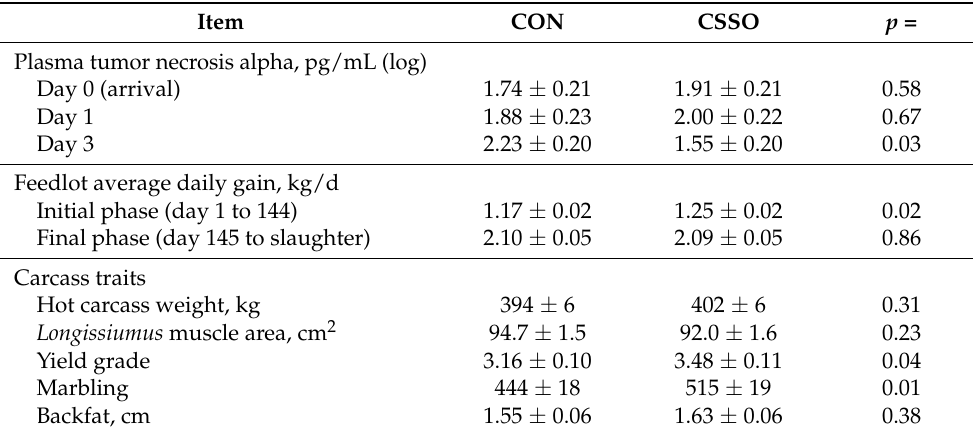
Table 6. Performance and health responses from steers supplemented or not (CON; n = 6) with Ca soaps of soybean oil (CSSO; n = 6) for 28 days prior to feedlot arrival (day 0). Values reported are least square means ± standard error. Adapted from Cooke et al. [9].